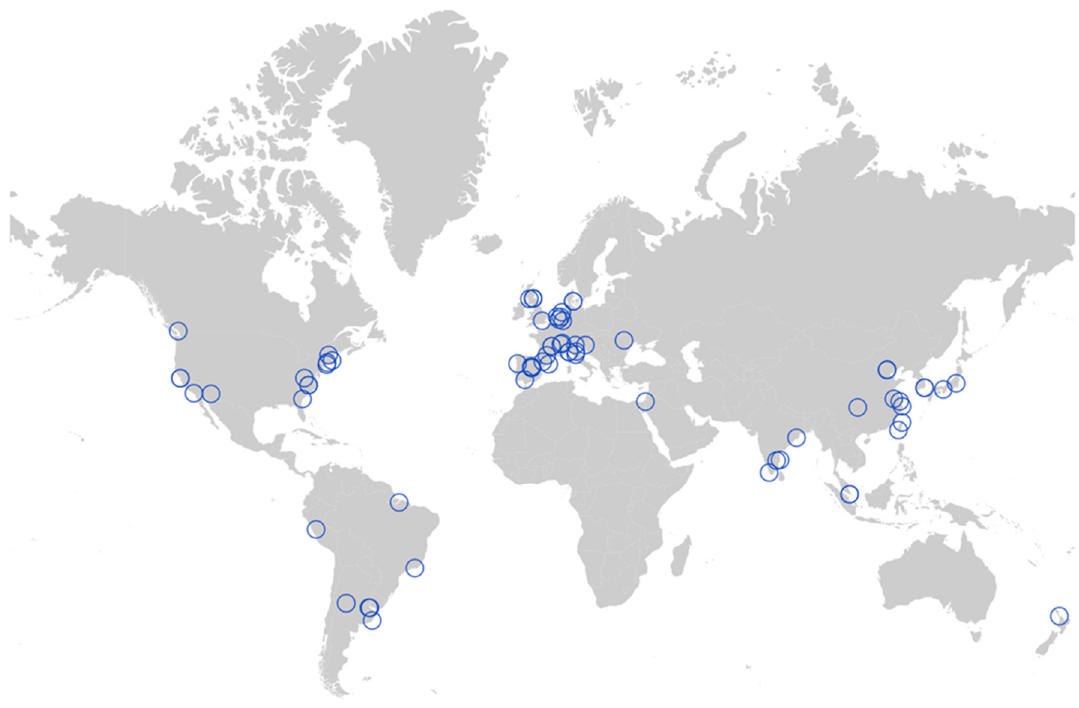
Figure 5. Geographical distribution of atypical HFMD. Data are visualized with the help of online website services (https://www.chiplot.online/map_plot.html, accessed on 3 January 2023).